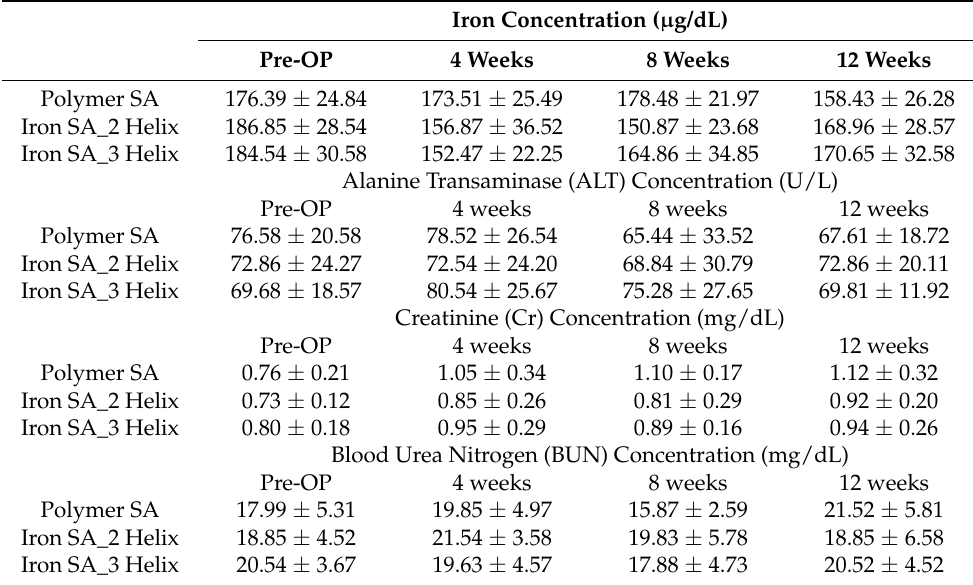
Table 6. Blood biochemistry analysis.